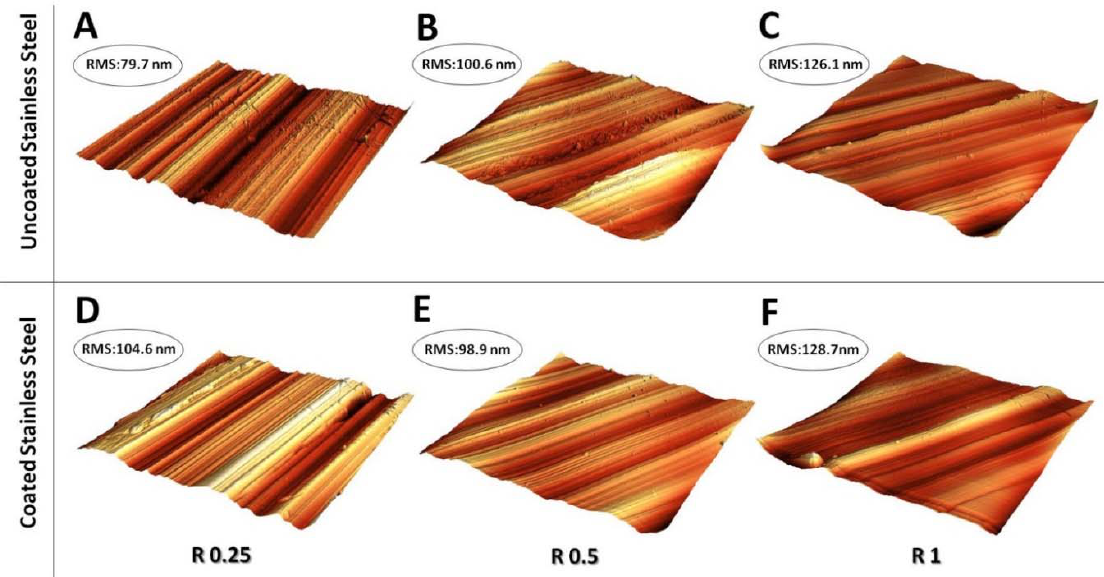
Figure 11. Small range (30 × 30 μ m) 3D AFM topographic reconstruction of stainless steel disk surface before ( A–C ) and after ( D–F ) nanoXHAM ® D surface treatment. The relative large ‐ scale roughness values (R 0.25, R 0.5 and R 1) are indicated at the bottom of panels. RMS roughness values correspondent to each scan are reported in the top left corner.